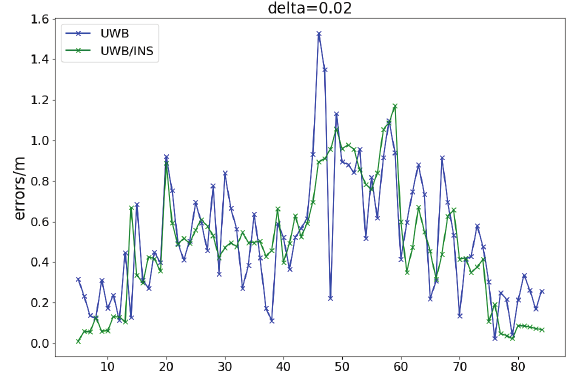
trajectory figure and error figure of the two observation noise covariance matrices are shown in Figures 8 to 11.